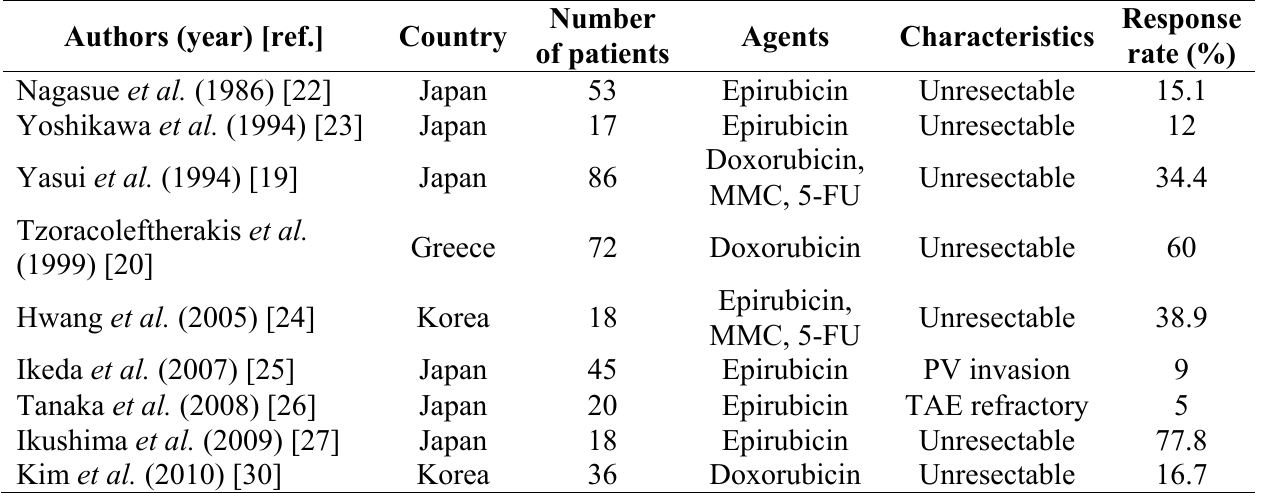
Table 1. Reports of HAIC with anthracycline-based chemotherapeutic agents for advanced hepatocellular